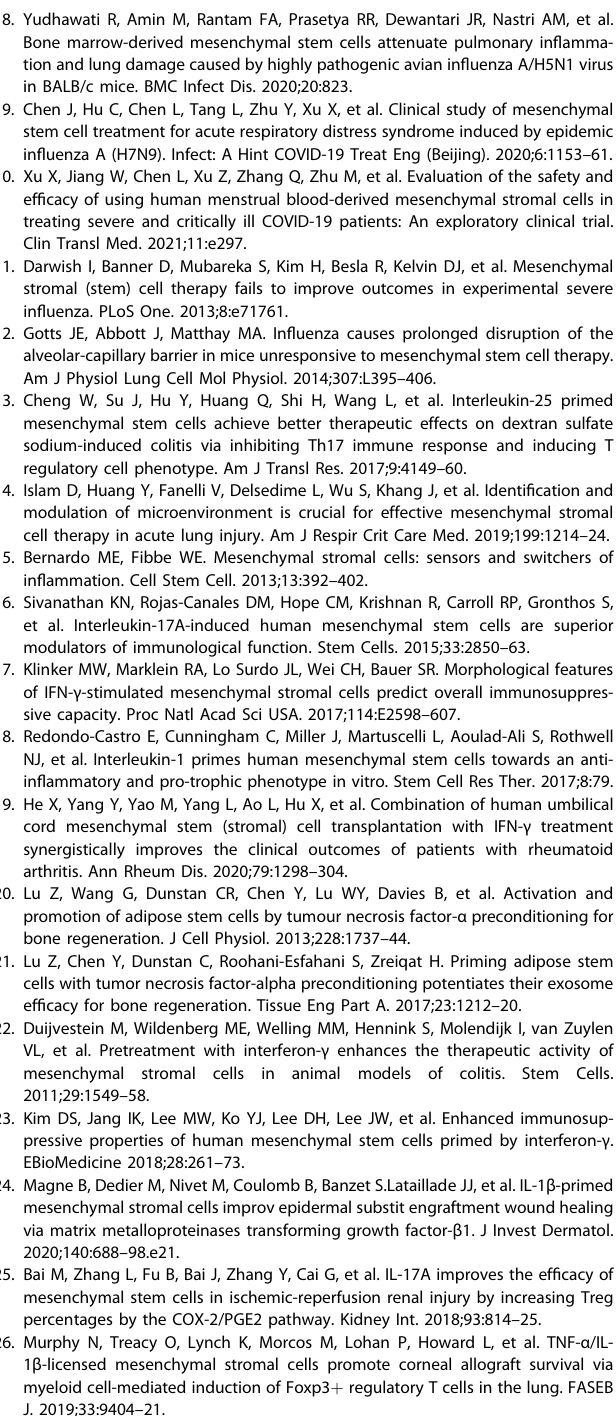
Fig. 7 TGF- β 1 is the key factor that participates the immunosuppression and anti-apoptosis pathways of IL18-hUCMSC in vitro and in vivo. A , B The proliferation level of human CD3 + T-cells was analyzed by fl ow cytometry; the change of CFSE fl uorescence intensity indicates the growth ratio (A); and the immunosuppression ratio was analyzed statistically ( B ). C , D Representative fl ow cytometric images with Annexin V/7-AAD double staining assay of cells treated with or without PR8 virus ( C ); Quanti fi cation of Annexin V - 7AAD - live cells is shown: (Annexin V - 7AAD - cell amount / total cell amount) × 100% ( D ). Human MRC-5 cell line and mouse alveolar epithelial cells were used in apoptosis experiments in vitro. E , F The cell apoptosis in lung tissues was analyzed by fl ow cytometry, and 7AAD + cells were regarded as apoptotic cells ( E ); the percentages of Annexin V - 7AAD - live cells in different groups were calculated at 7 dpi ( G ). Fresolimumab (GC1008) and TGF- β Ab is the blocking reagent that target to TGF beta-1,2,3. Data are shown as mean ± SEM. n = 3 – 5 in each group. * p < 0.05, ** p < 0.01, *** p < 0.001, ns = not signi fi